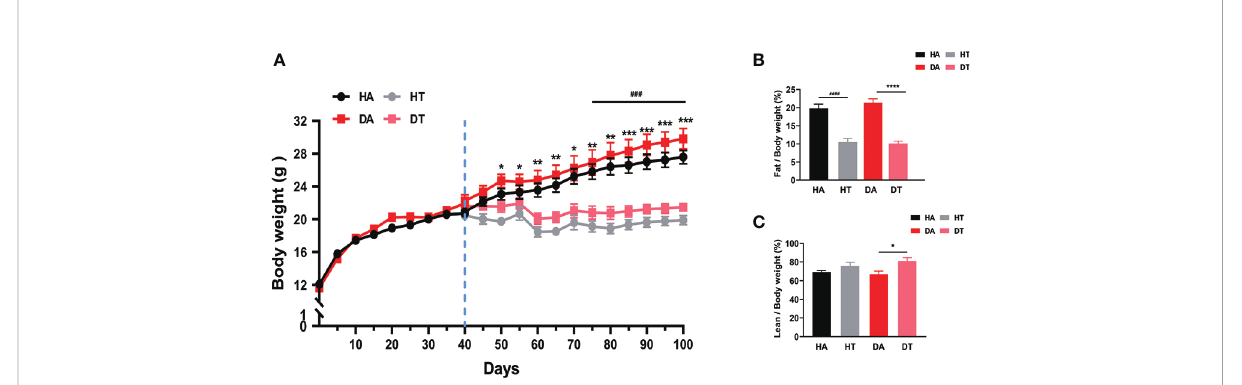
FIGURE 2 Time-restricted feeding (TRF) prevents weight gain and reduces body fat mass in mice. Growth curves and body fat composition for four groups. HA group: high-fat diet (HFD) feeding mice with ad libitum ; dihydrotestosterone (DHEA) and ad libitum feeding (DA) group: mice were given an HFD and water ad libitum ; HFD and TRF intervention (HT) group: mice were given an HFD as well as a TRF dietary pattern; DHEA and TRF intervention (DT) group: mice were given an HFD as well as a TRF dietary pattern. (A) Growth curves for four groups. (B, C) Body fat test. Values are mean ± SEM. *P<0.05, **P < 0.01, ***P< 0.001, ****P<0.0001, DA group vs. DT group; ### P<0.001, #### P<0.0001, HA group vs. HT